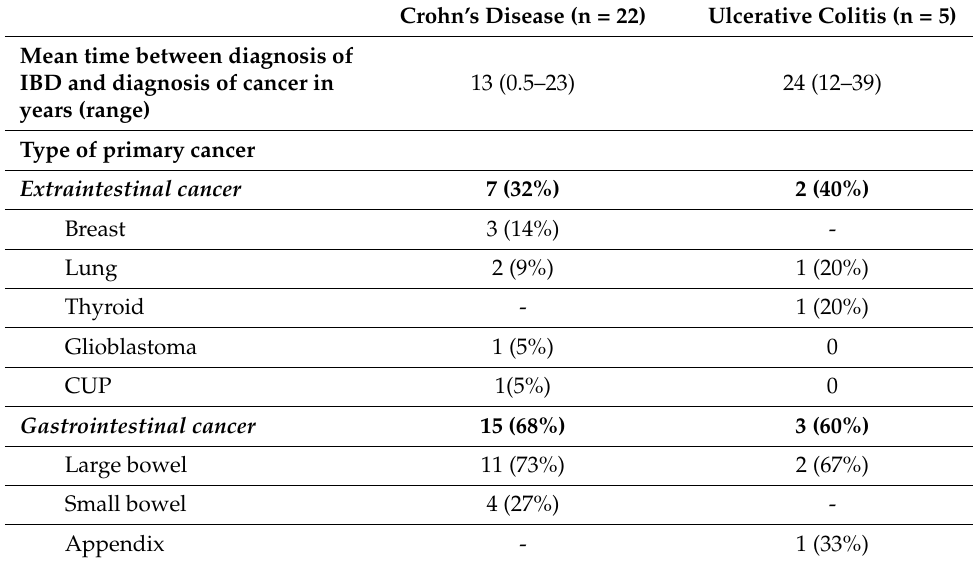
Table 3. Type of cancer depending on underlying IBD type: Crohn’s disease vs. ulcerative colitis; CUP: carcinoma of unknown